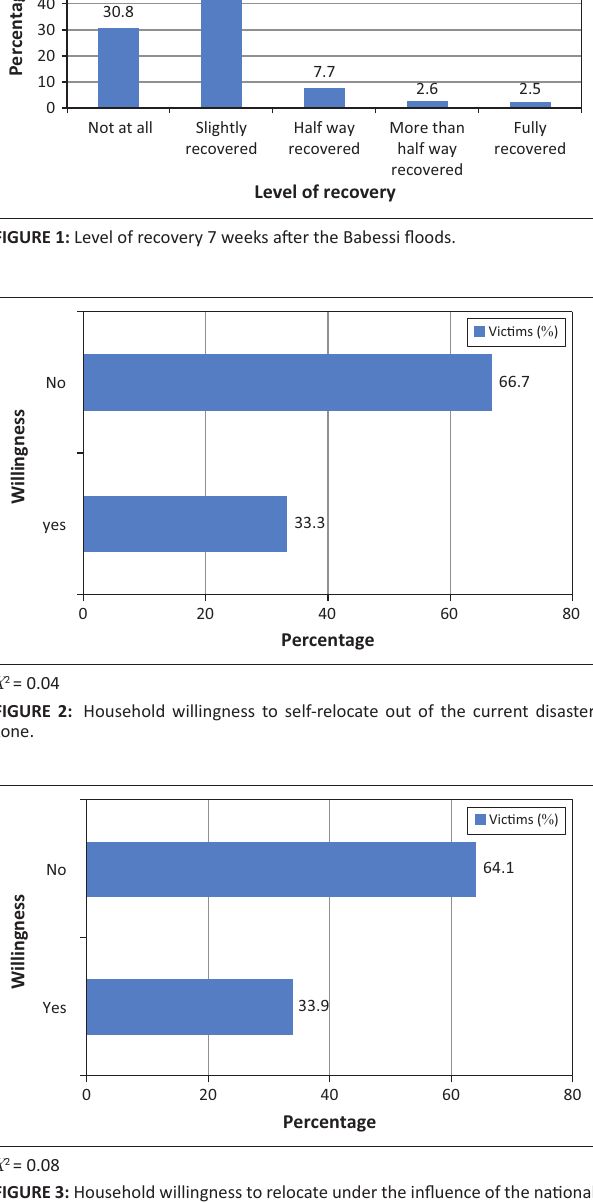
TABLE 5: Value of books and number of lives lost by households to the Babessi floods. Variable